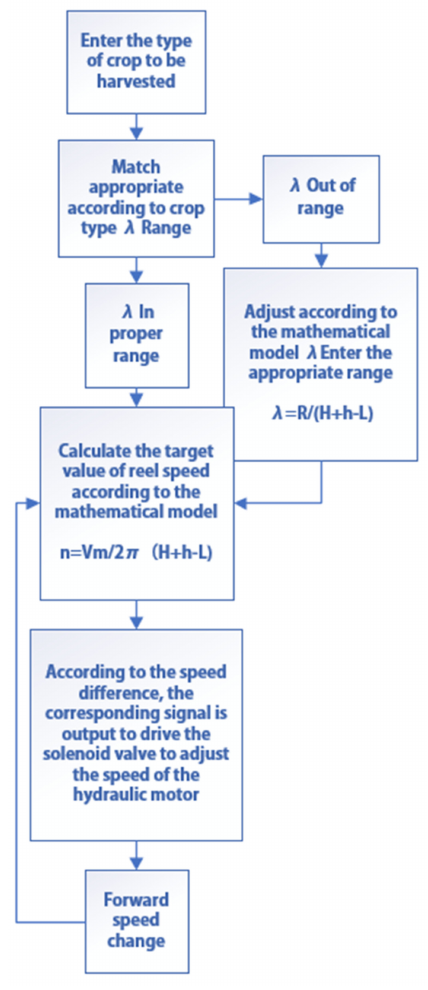
Figure 8. Control flow